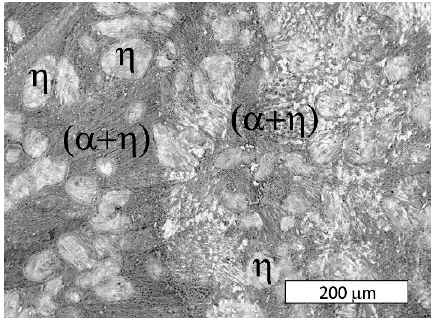
Figure 10. SEM image of the surface of a sample after polarization up to a potential of +300 mV vs. E corr . Corrosion initiation locations of the Zn-4Al alloy are visible. The dark areas represent areas of the eutectic alloy affected by corrosion.